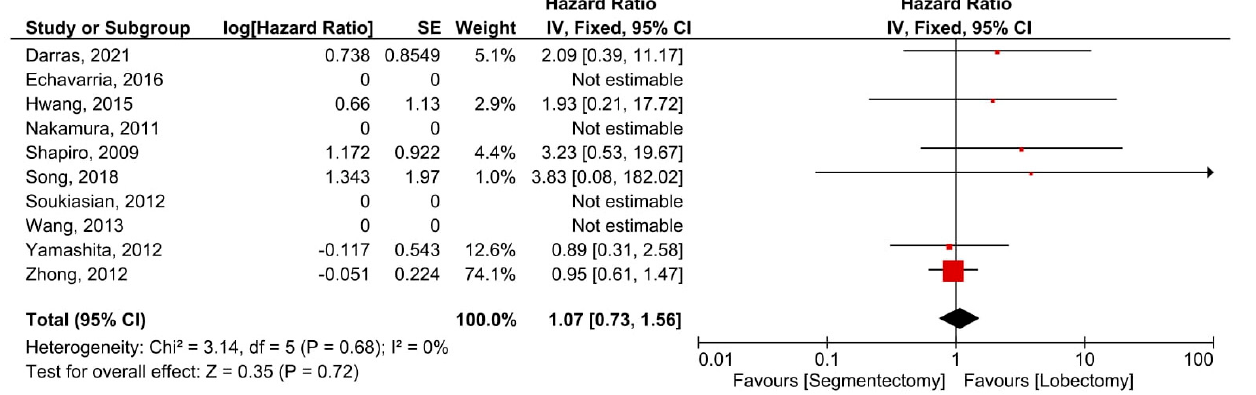
Figure 6. Forest plot for disease-free survival of the minimally invasive segmentectomy and lobectomy. CI = confidence interval; dF = degree of freedom; IV = inverse variance; SD = standard deviation [8,12–20].